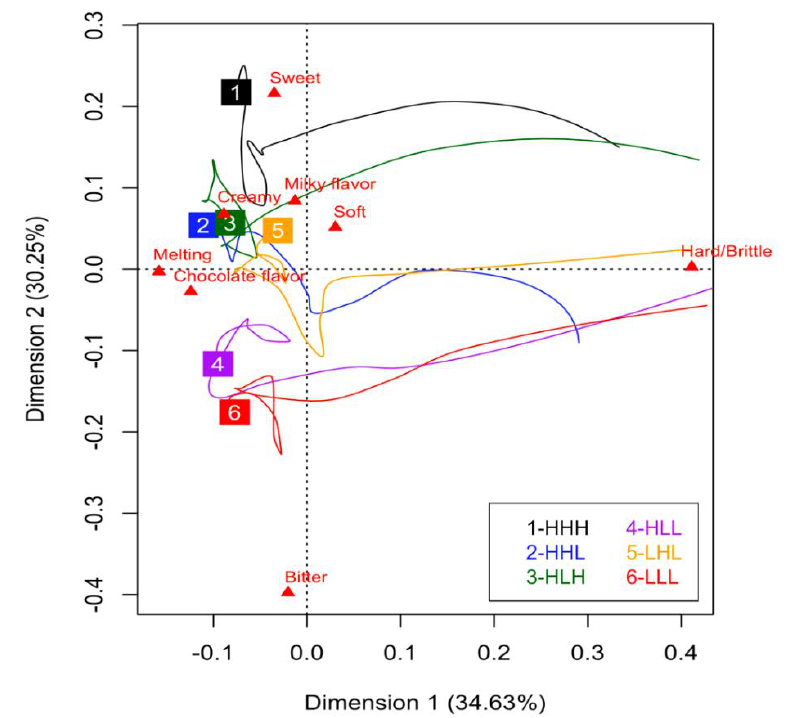
Figure 3. Principal Components Analysis (PCA) biplot representing the product trajectories of the six 3D printed chocolates during the TDS evaluation. Numbered squares represent trajectory end-points for the corresponding sample.